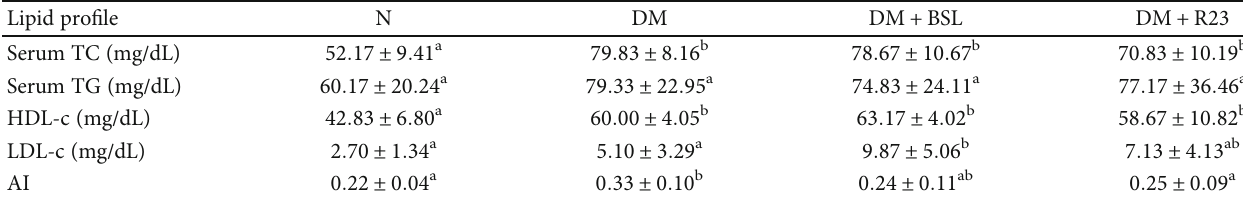
The values are expressed as the means ± SD ( n = 6 ). Means within a row with di ff erent superscript letters are signi fi cantly di ff erent ( P < 0 : 05 ). N= nondiabetic control group; DM=diabetic control group; DM + BSL = STZ treated with L. rhamnosus BSL; DM + R23 = STZ treated with L. rhamnosus R23.